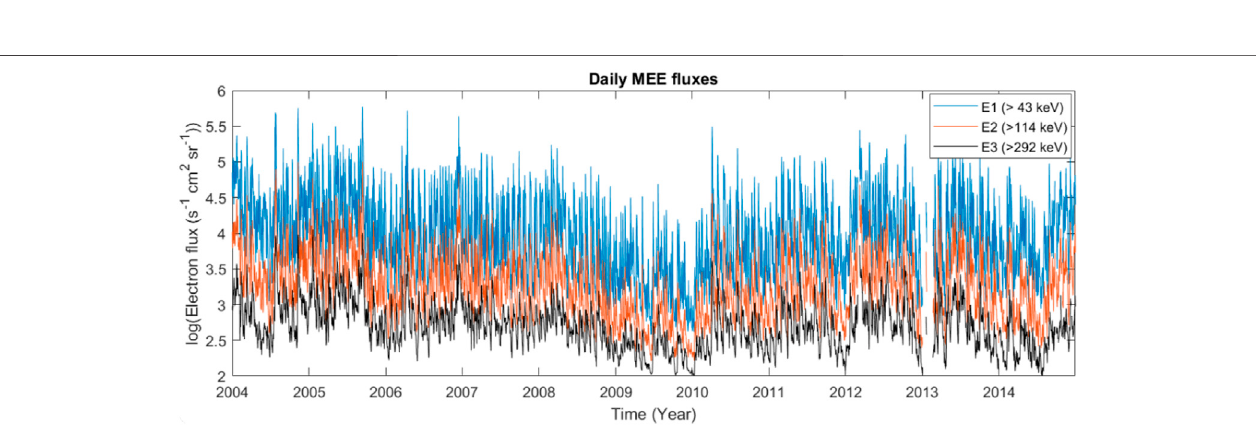
FIGURE 2 | Daily MEE of > 43 keV (blue line), > 114 keV (red line), and > 292 keV (black line) from 2004 to 2014. The fl uxes are averaged over all MLT and the CGM latitude band 55 ° – 70 ° N.